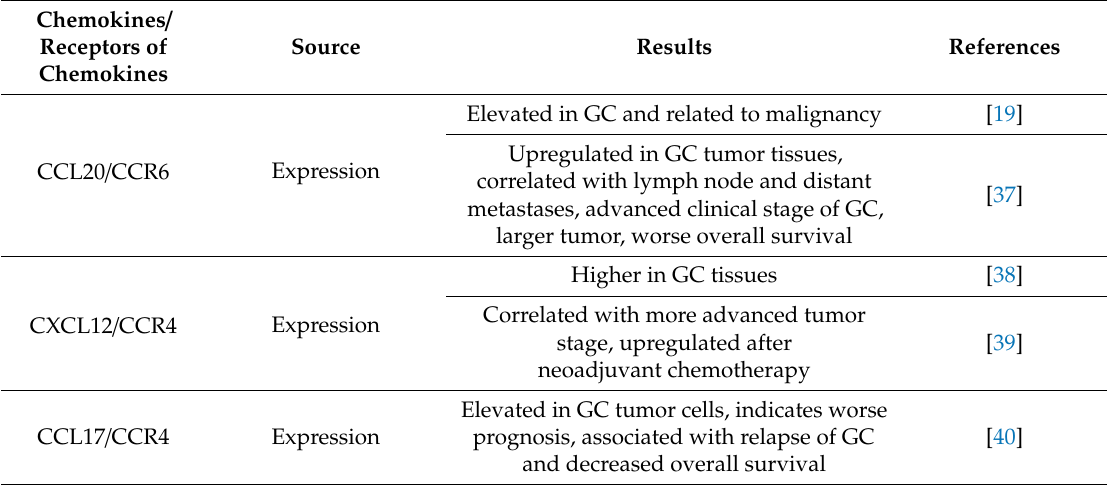
Table 3. The role of chemokine / receptor axis in gastric cancer